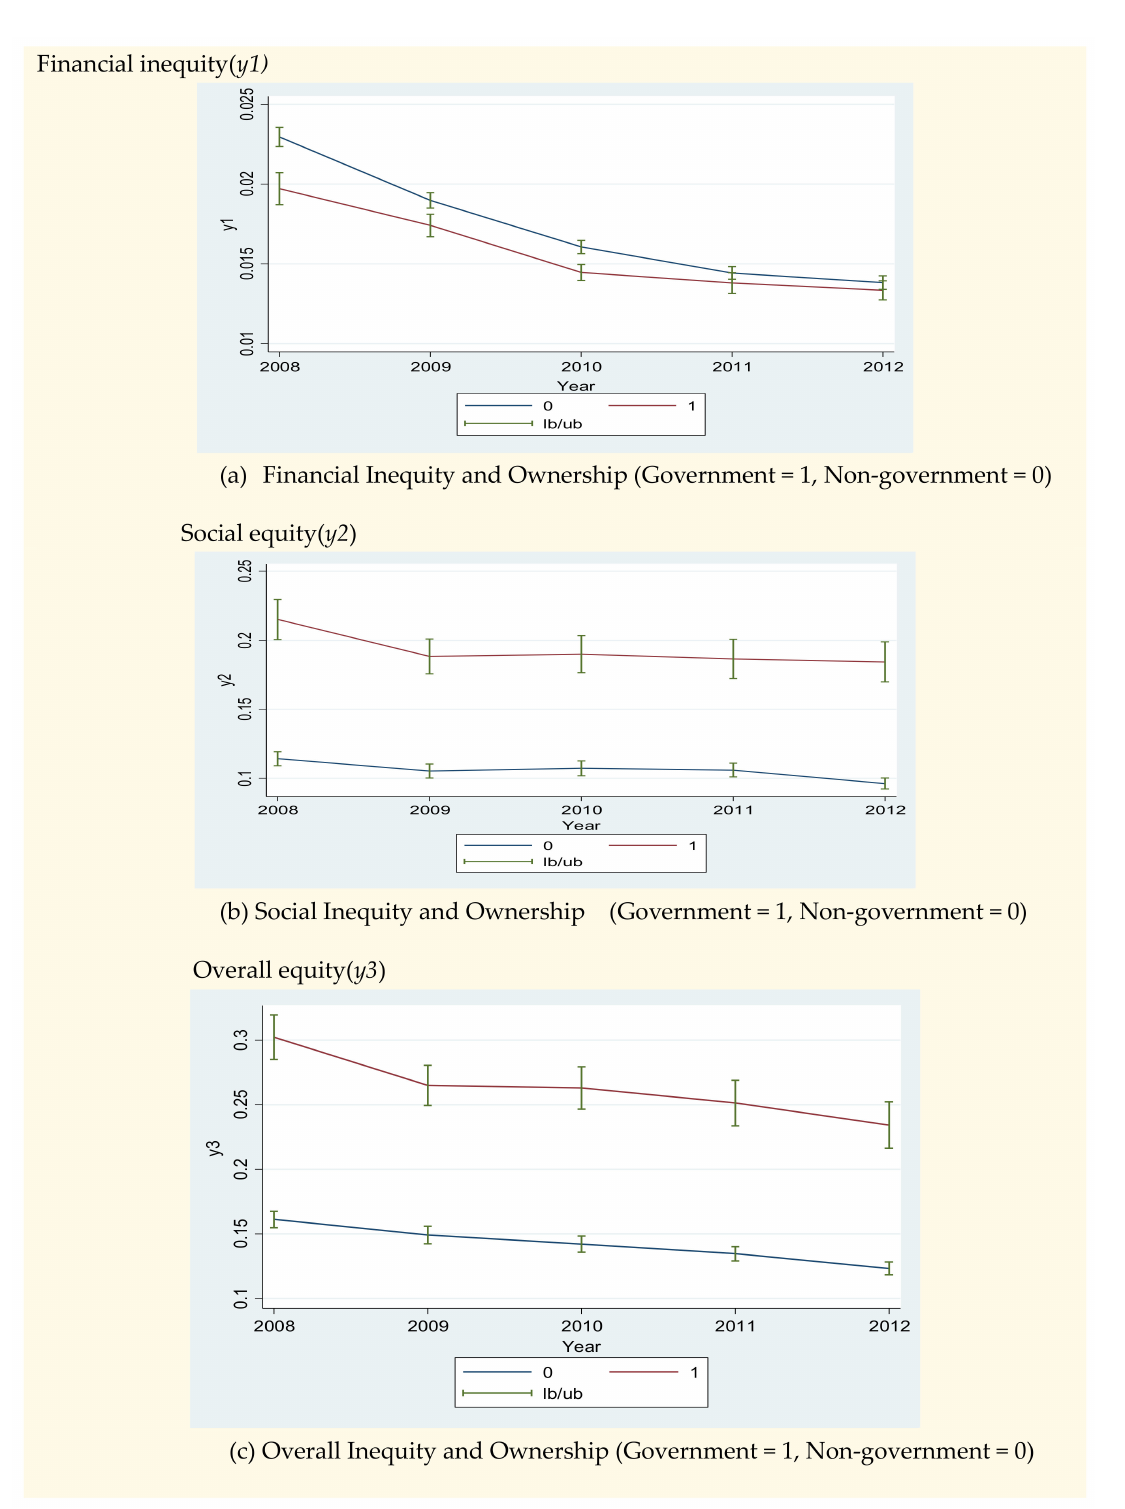
Figure 1. Comparing equity Indicators between public and nonpublic hospitals (2008–2012). Note: lb and ub are lower and upper boundaries of the 95% confidence